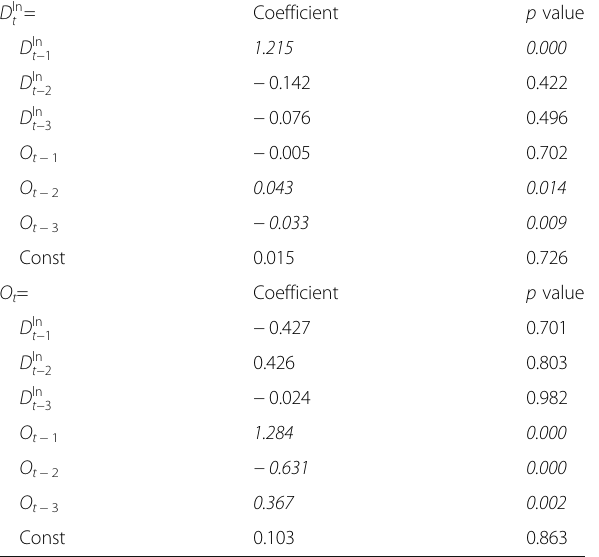
Table 6 Coefficients ’ estimations of a VAR (3) model between and O t for boom phases. Top: model for D ln the D ln t model for O t . Italics: significant results with 5% level